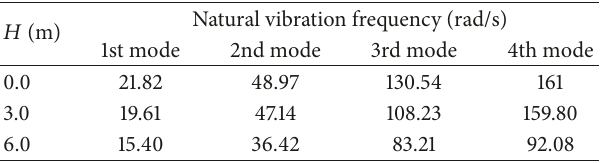
Table 1: Four first natural frequencies of the pitched-roof frame. 𝐻 (m) Natural vibration frequency (rad/s) 1st mode 2nd mode 3rd mode 4th mode